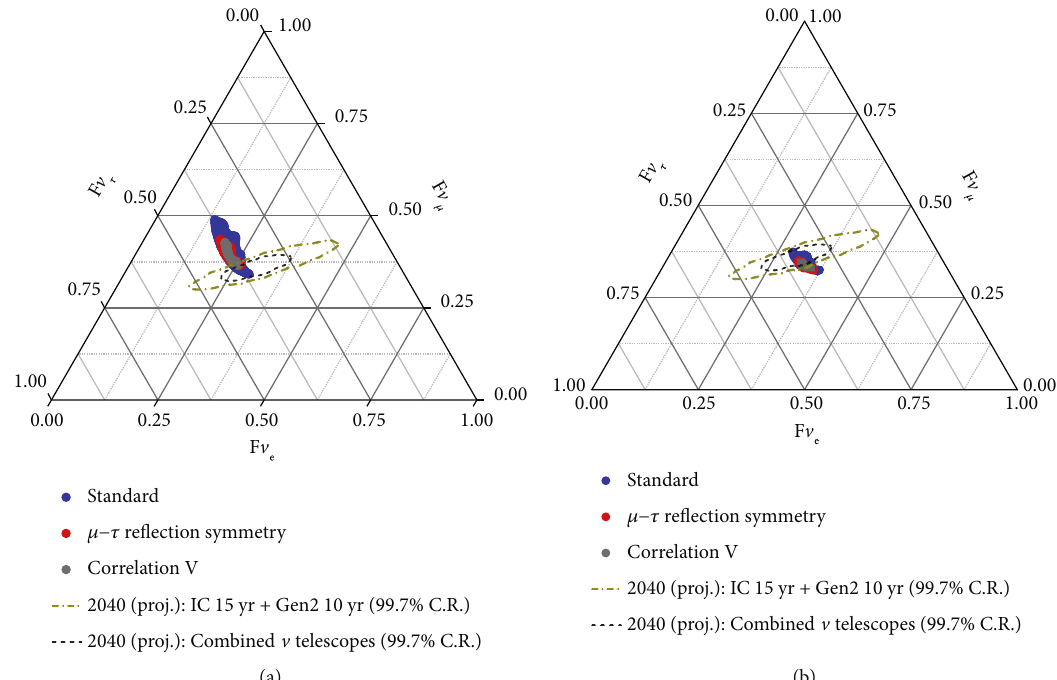
Figure 13: Ternary plot of the fl avor ratio at Earth with the muon-damping decay source (a) and the pion-decay source (b) based on the geometric constraints of the correlation V. The conventions of parameters and colors are the same as those in Figure